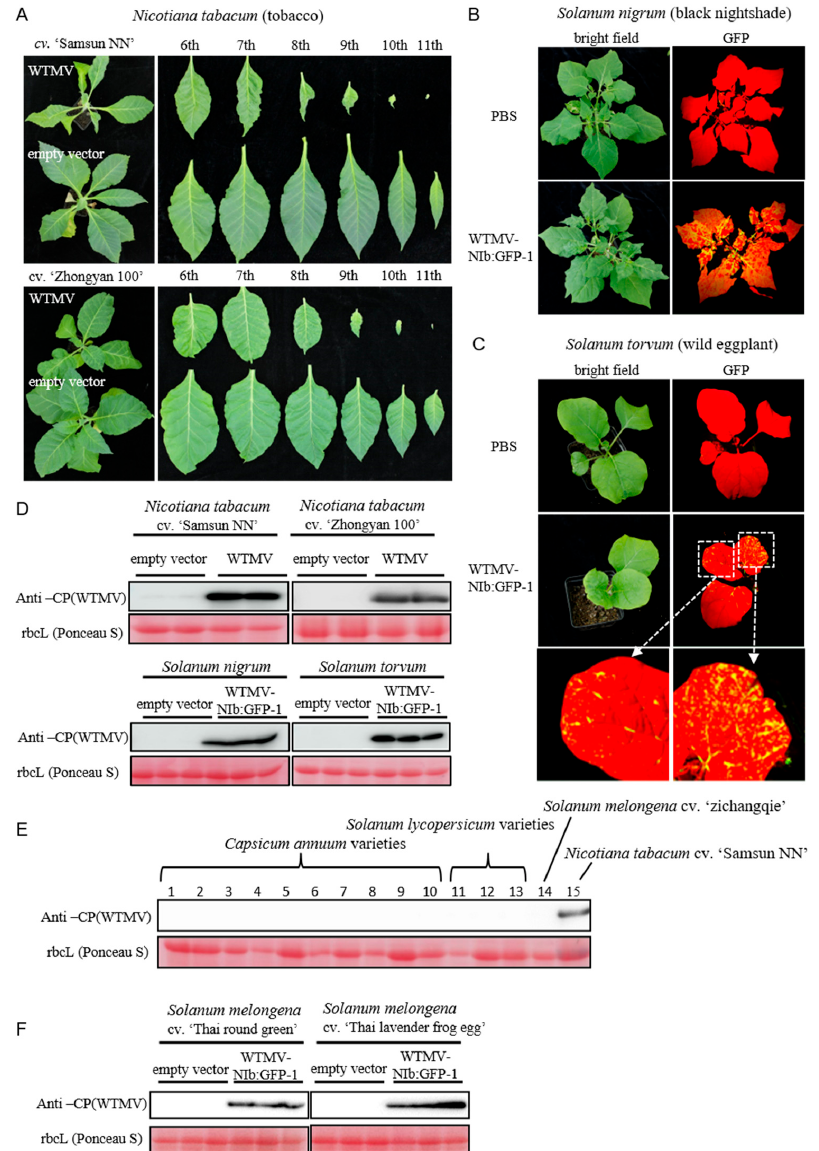
Figure 3. Infectivity of WTMV infectious clone on solanaceous plants. ( A ) The phenotypes of whole plants (left panels) or leaves (right panels) of the N. tabacum agroinfiltrated with WTMV infectious clone. The leaf positions are shown. The N. tabacum agroinfiltrated with empty vector is used as a negative control. The photographs were taken one-month post-infiltration. ( B ) The phenotypes of Solanum nigrum plant rub-inoculated with WTMV-NIb:GFP-1 contain inoculum. The plants inoculated with PBS are used as the control. The photographs were taken 2 weeks post-inoculation. The yellow regions indicate the infection of WTMV. ( C ) The phenotypes of Solanum torvum plant rub-inoculated with WTMV-NIb:GFP-1 contain inoculum. See more detail in panel ( B ). ( D ) Western blotting analysis of the plants is described in panels ( A – C ). The samples are obtained from the upper leaves of the plants after taking photographs. The different lanes for each treatment indicate biological repeats. ( E ) Western blotting analysis of Capsicum annuum , Solanum lycopersicum , and Solanum melongena , which agroinfiltrated with the WTMV infectious clone. The different lanes for each species indicate different varieties. The sample obtained from WTMV infected N. tabacum cv. ‘Samsun NN’ is used as a positive control. ( F ) Western blotting analysis of S. melongena cv. ‘Thai round green’ and cv. ‘Thai lavender frog egg’ infected with WTMV-NIb:GFP-1. The samples are obtained from the upper leaves of the plants 2 weeks post-inoculation. The different lanes for each treatment indicate biological repeats. Ponceau S stained rubisco large subunit (rbcL) is used as the loading